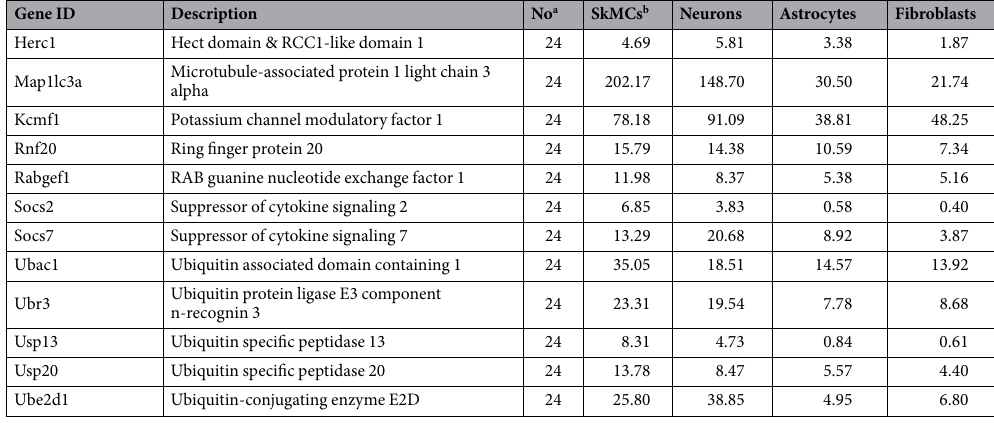
Table 1. Expression of biological processes-associated host cell genes that are differentially enriched in the transcriptomes of SkMCs and neurons versus astrocytes and fibroblasts. a Cluster number. b Data represent RPKM